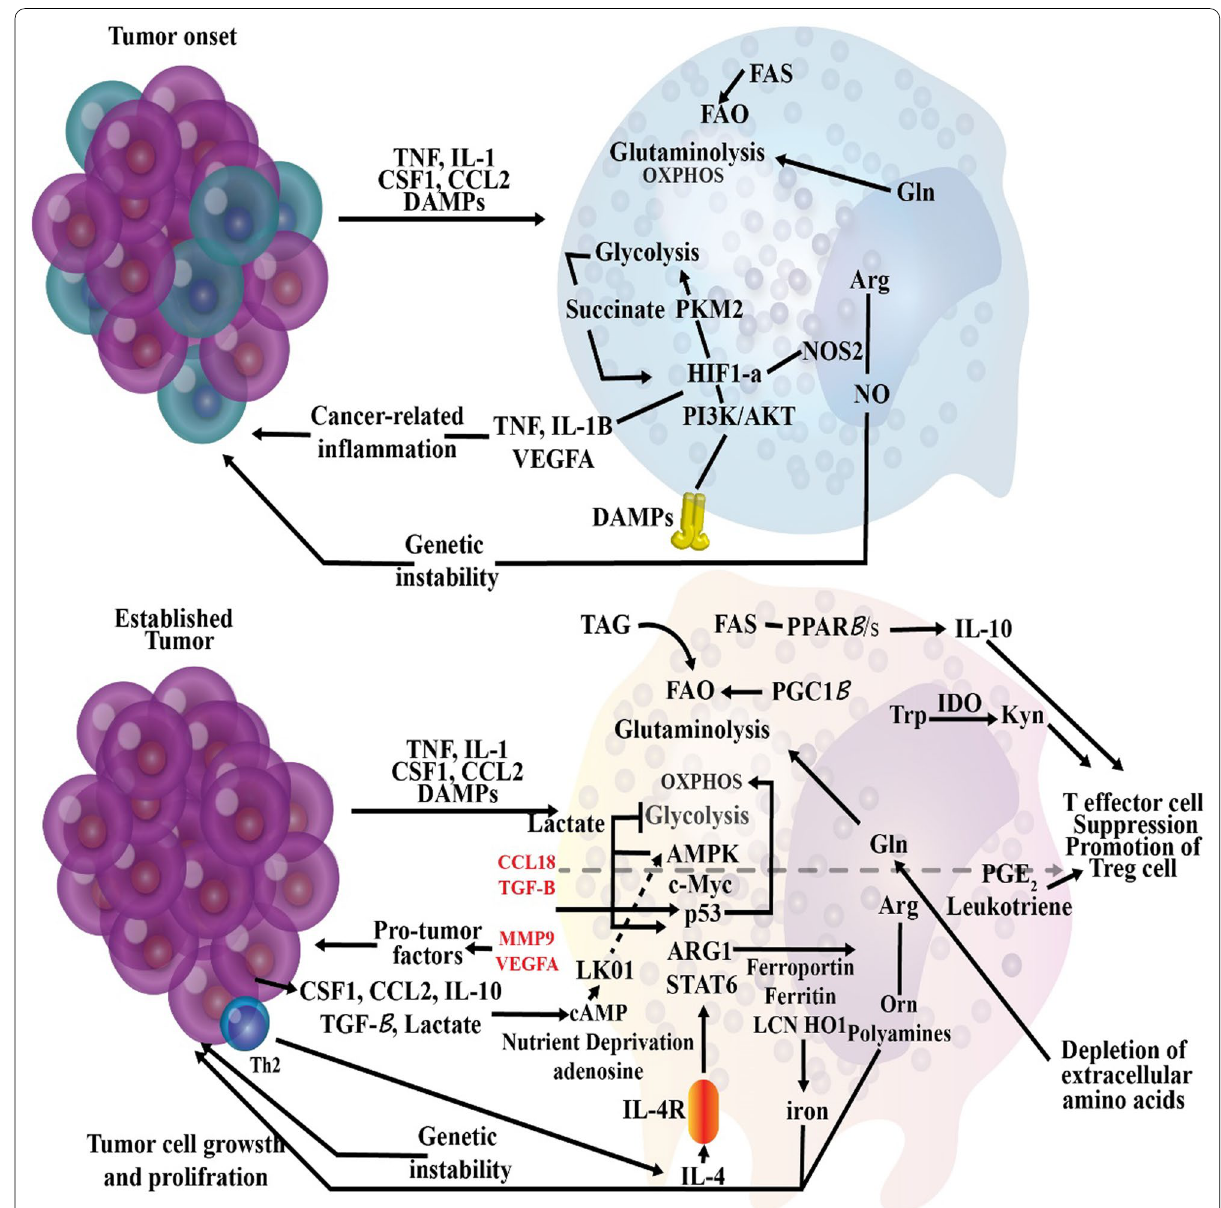
Fig. 4 Metabolic reprogramming of immune cells and their altered functions to cancer cells. A) Metabolic shift in tumor-associated macrophages (TAMs) at tumor onset and during progression. At tumor onset, a glycolytic shift, activation of HIF1α, and inhibition of oxidative phosphorylation (OXPHOS) induce the expression of NO, ROI, and inflammatory cytokines such as IL-1β and TNF in inflammatory macrophages to support cancer-related inflammation and genetic instability that leads to tumorigenesis. At established tumors, nutrient deprivation-induced AMPK activation, Th2-derived IL-4 (which activates STAT6, p53, c-Myc, and PGC1β), lactate accumulation, and PKM2 activation suppress glycolysis in TAMs while upregulating OXPHOS. This metabolic change induces immunosuppressive TAMs that promote tumor growth. Changes in the metabolism of iron, amino acid, and fat that contribute to this process are also